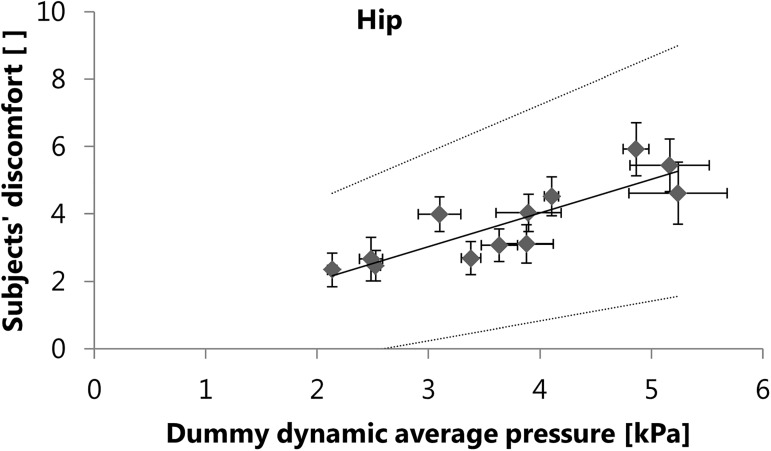
Results of the regression analysis using the pressure parameters measured on the dummy as independent variables.Dynamic average pressure measured on the dummy is a significant (p<0.001) predictor of the subjects’ discomfort in the hip region. Data points show the mean ± standard error of measurement for each configuration, dotted lines show 95% prediction intervals. Regression equation: y = 0.999x + 0.041, R2 = 0.75.